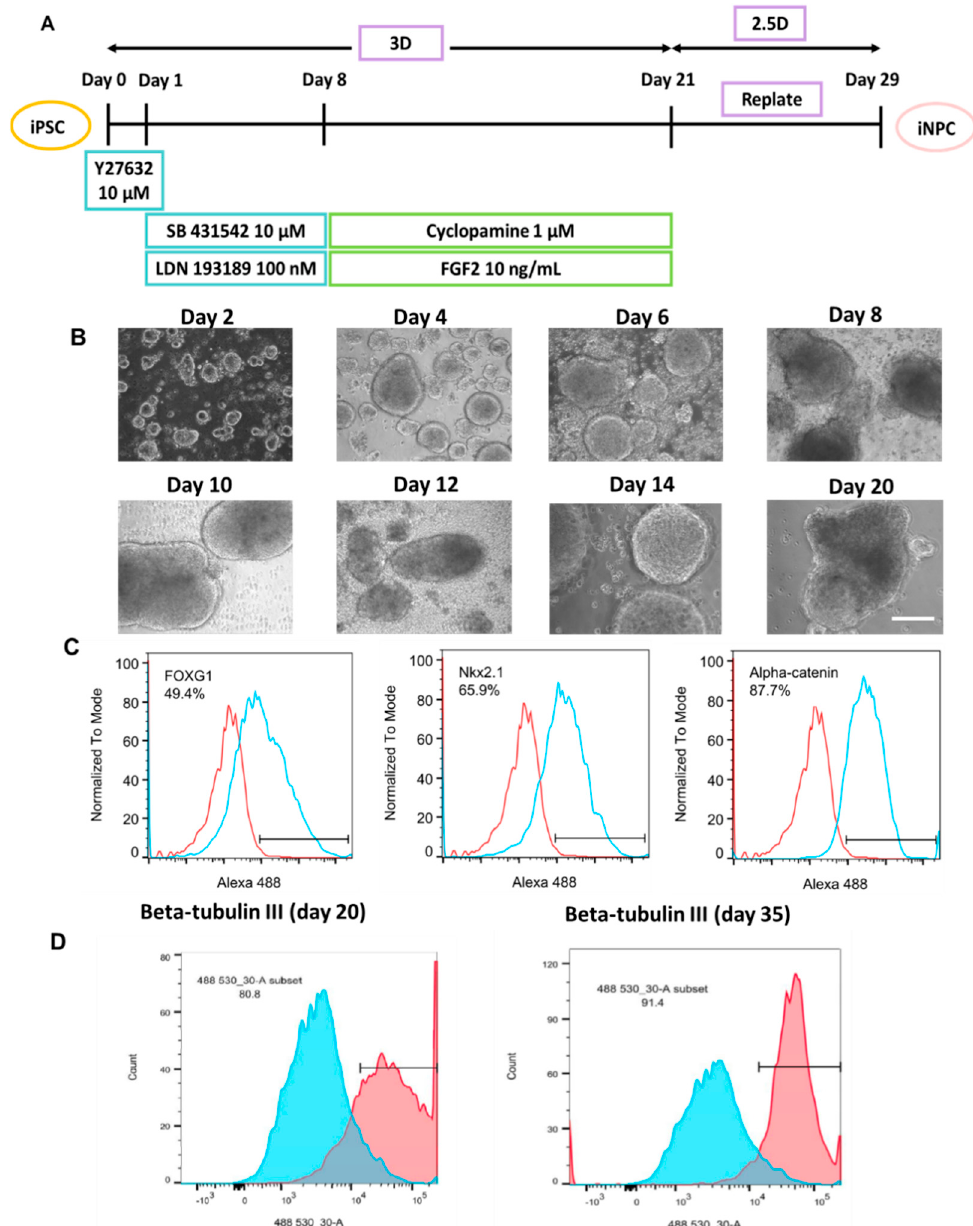
Figure 1. Characterization of cortical organoids derived from hiPSCs for EV collection. ( A ) Schematic illustration of cortical organoid differentiation from hiPSCs ( B ) Morphology of cortical organoids derived from hiPSCs; Scale bar: 200 μ m. ( C ) Flow cytometry analysis of cells from cortical organoids for FOXG1, Nkx2.1, and α − catenin. Red line: negative control; Blue line: marker of interest. ( D ) Flow cytometry analysis of β -tubulin III. Blue: negative control.